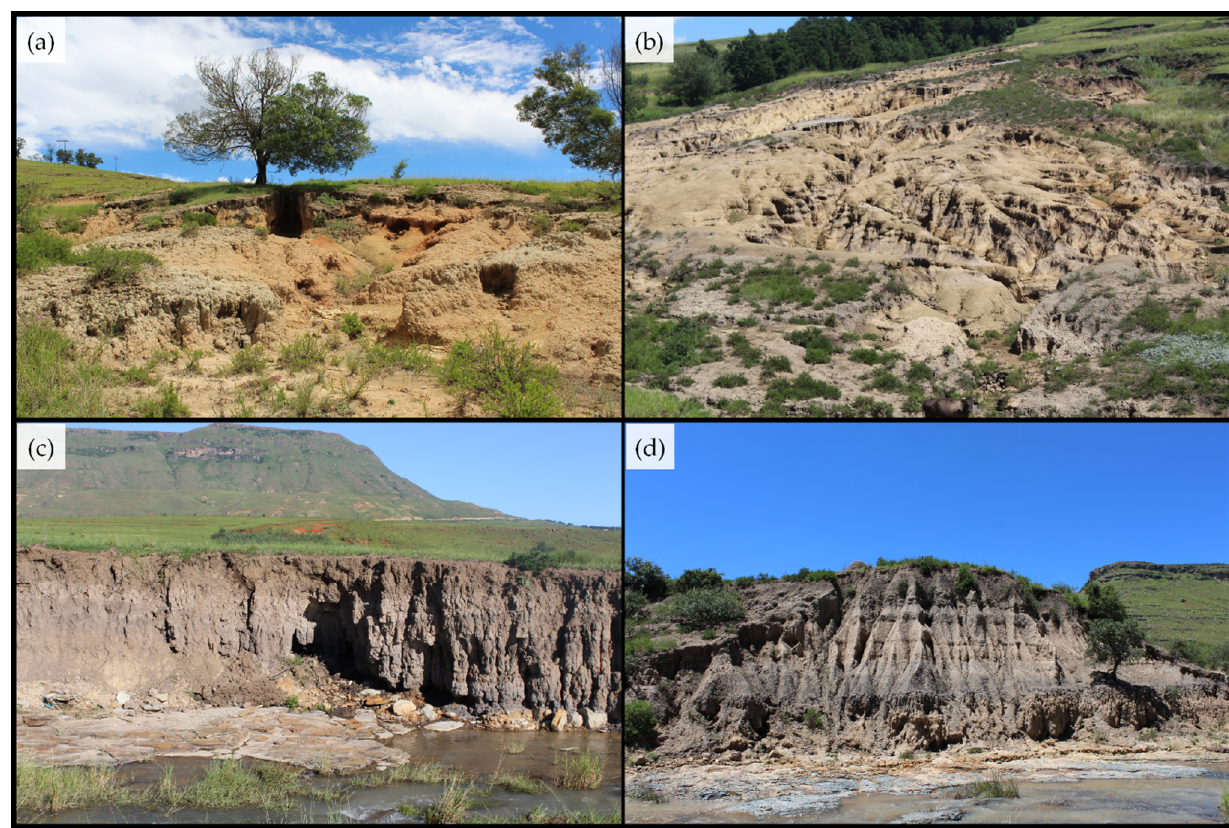
Figure 3. Gully erosion in the upper Mkhomazi River basin: ( a , b ) examples of type A gullies on hillslopes; ( c , d ) examples of type B gullies eroded into stratified colluvial sediments and buried paleosols at the base of the hillslope.